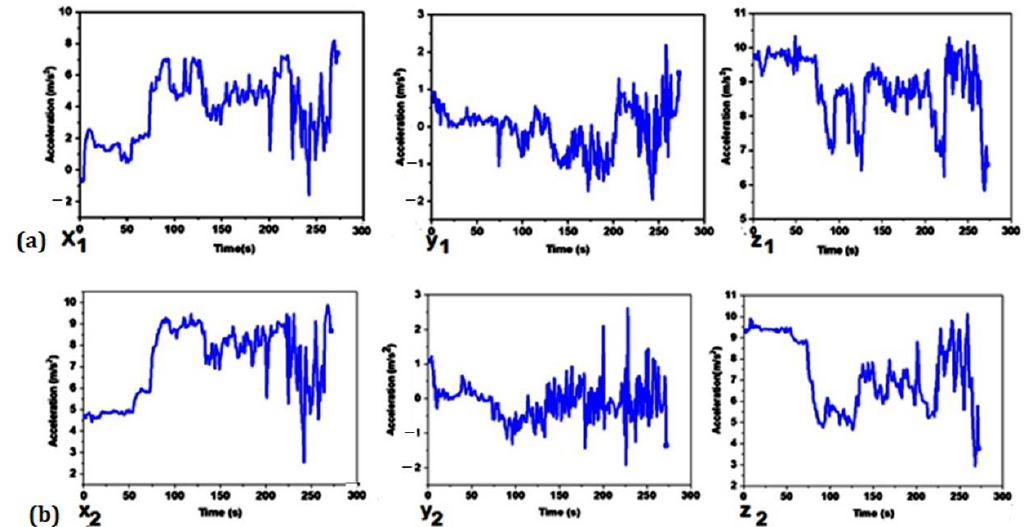
Figure 6. Top sensor ( a ) and bottom sensor ( b ) output acceleration for 3-axis accelerometer during 5 min of cycling.